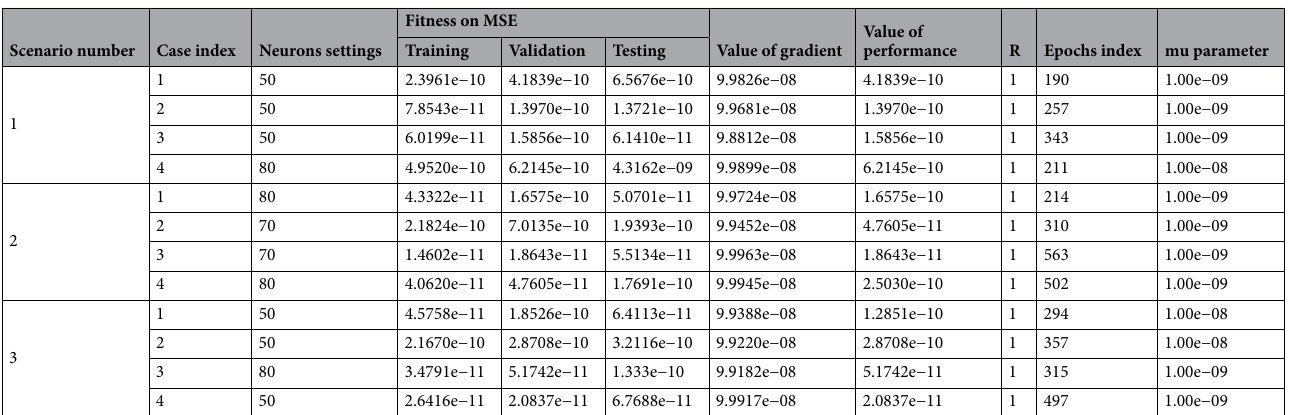
Table 4. Comparative analysis for all four cases of three scenarios of case study 1.